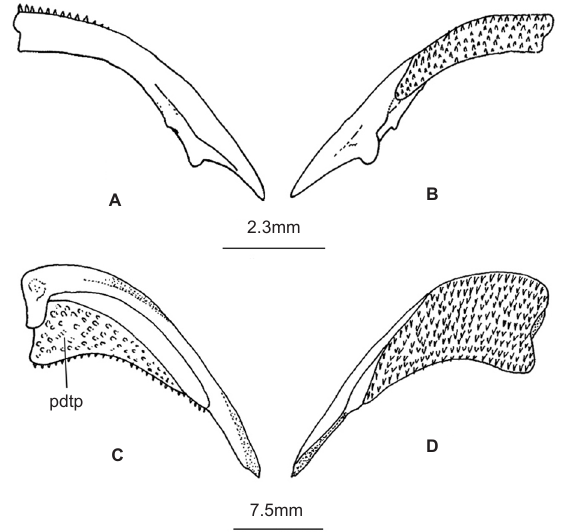
Figure 2. Dentary (left): A - ventral view, B - dorsal view of G. manipurensis (MUMF 4030); C - ventral view, D - dorsal of G. chindwinica (MUMF 9997). Pdtp - posterior extension of dentary bony